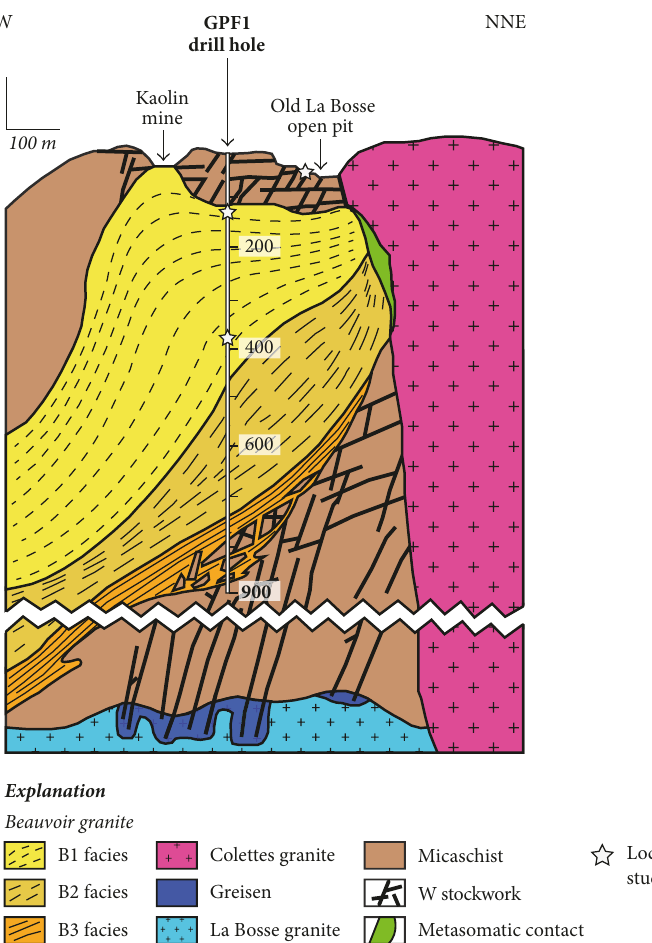
Figure 2: Interpretative cross-section of the Beauvoir granite from the GPF1 drill hole showing the vertical magmatic internal zoning composed by the three successive facies B1, B2, and B3 (modified from [12]). The location of the samples studied in this work is also